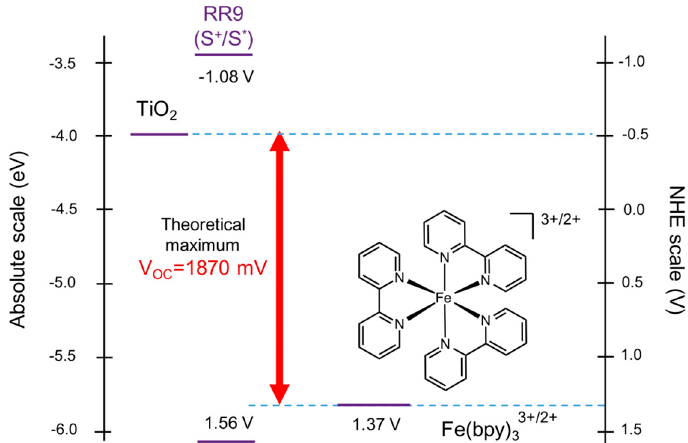
Figure 8. Energetic scheme of DSSC with RR9 and Fe(bpy) 33+/2+ electrolyte. Data from Rodriguez, et al . (2018)